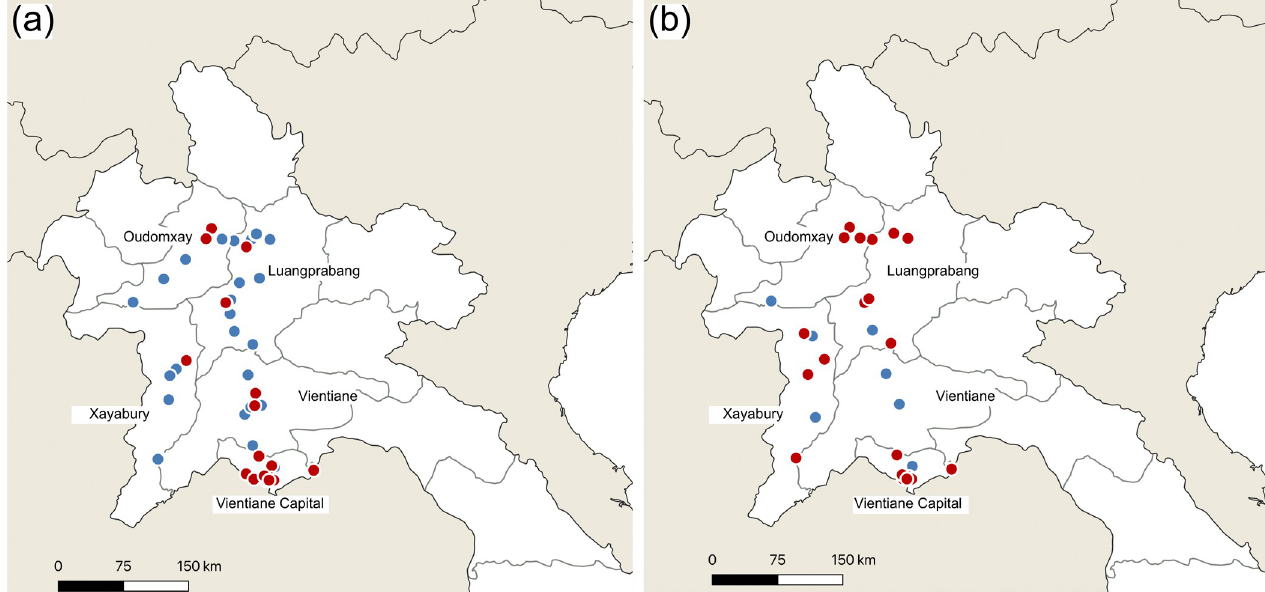
Fig 1. Geographical locations of food markets under observations in Laos. (a) dry season, (b) rainy season. Red circles indicate markets where at least one species of edible insects was observed. Blue circles indicate markets where no edible insect was observed.